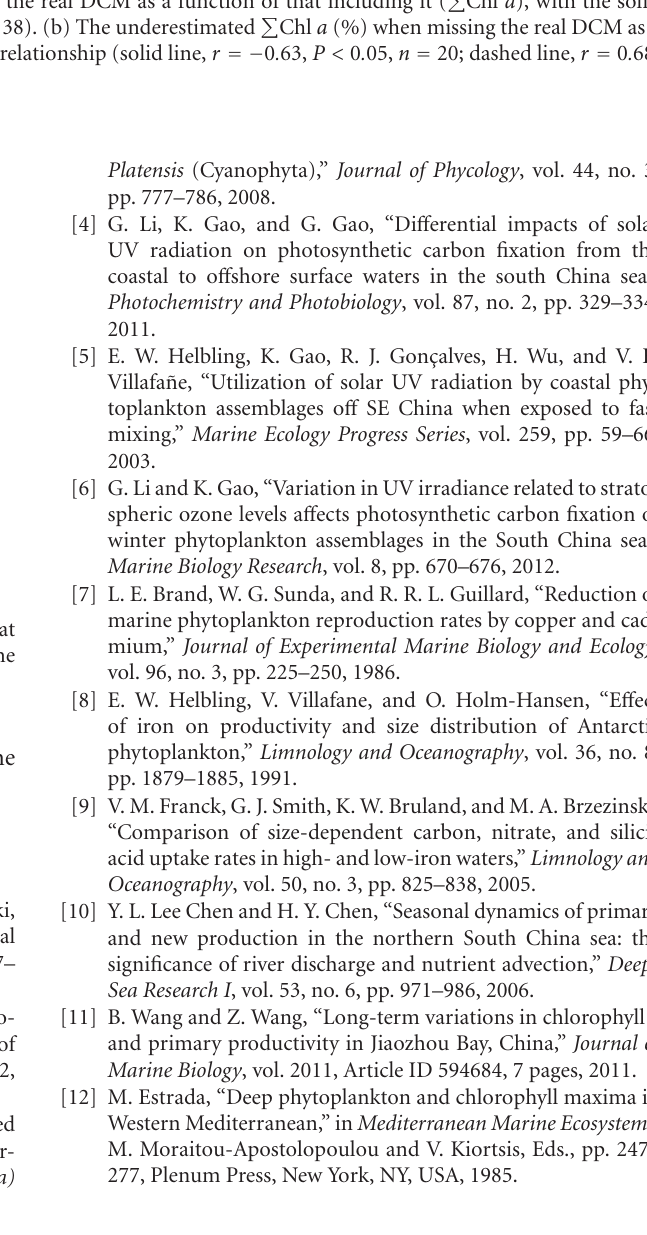
(cid:2) Chl a ), with the solid (cid:2) Chl a (%) when missing the real DCM as a